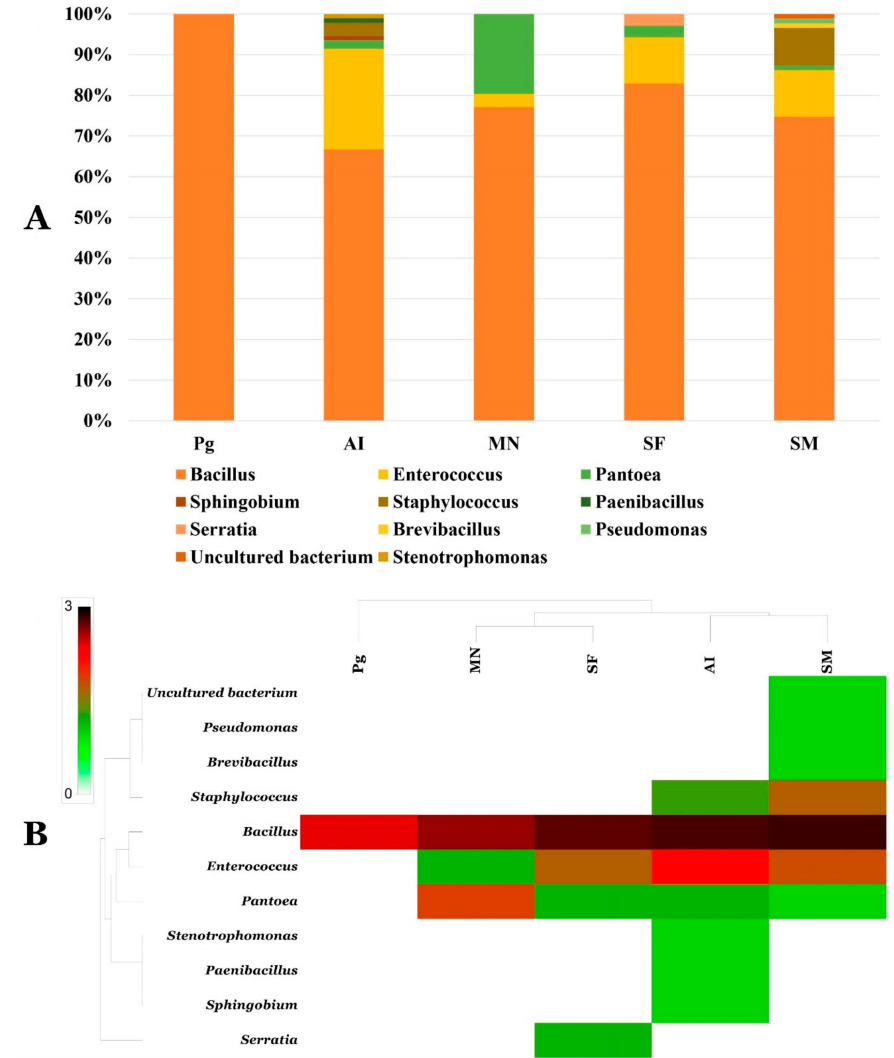
Figure 6. Bar chart showing diversity ( A ) and Heat-map of genera abundance of culturable Phosphogypsum and plant microbiomes ( B ).